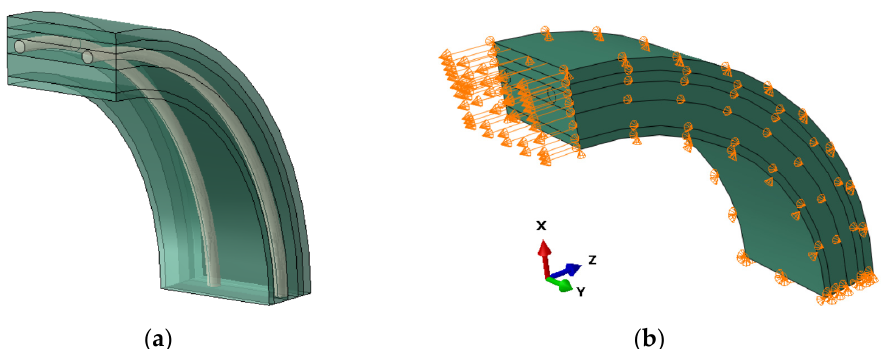
Figure 7. Simplified FEM model for the strain energy calculation: ( a ) general configuration; ( b ) boundary condition.